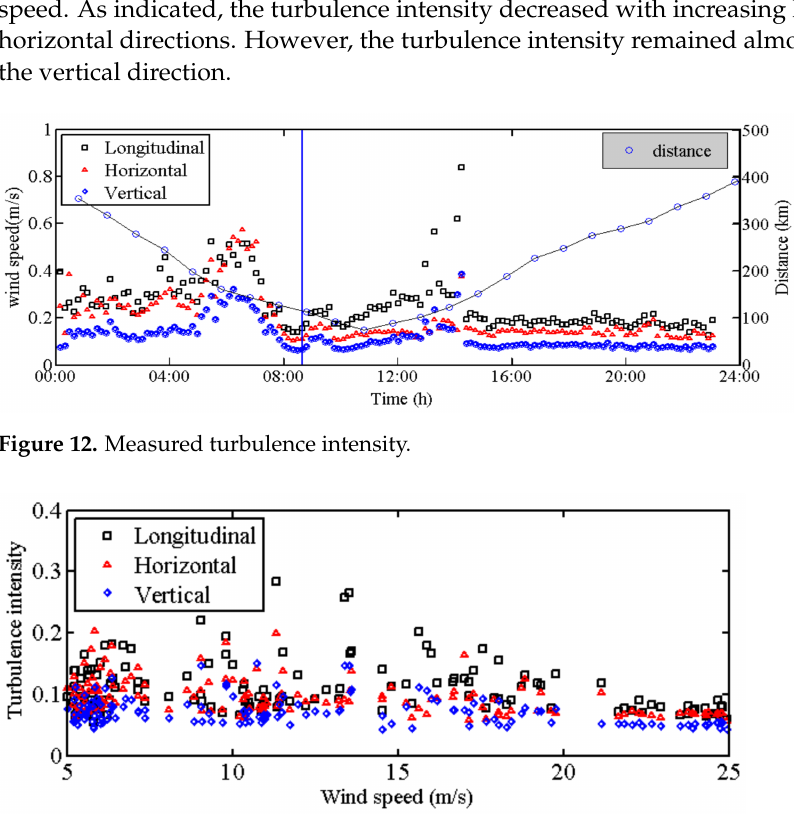
Figure 13. Measured turbulence intensity via wind